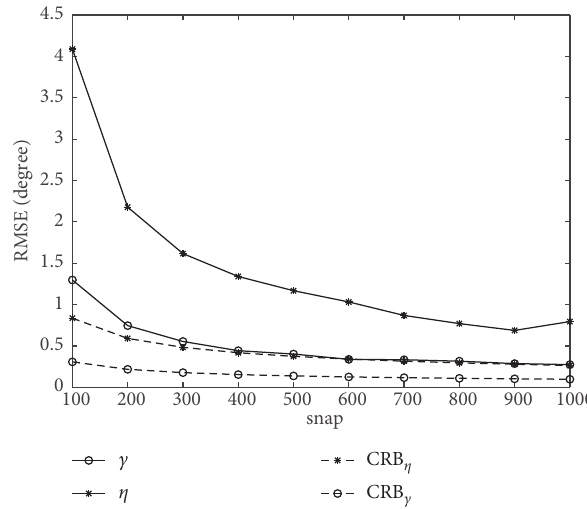
Figure 10: RMSE of polarization parameters with different SNR.